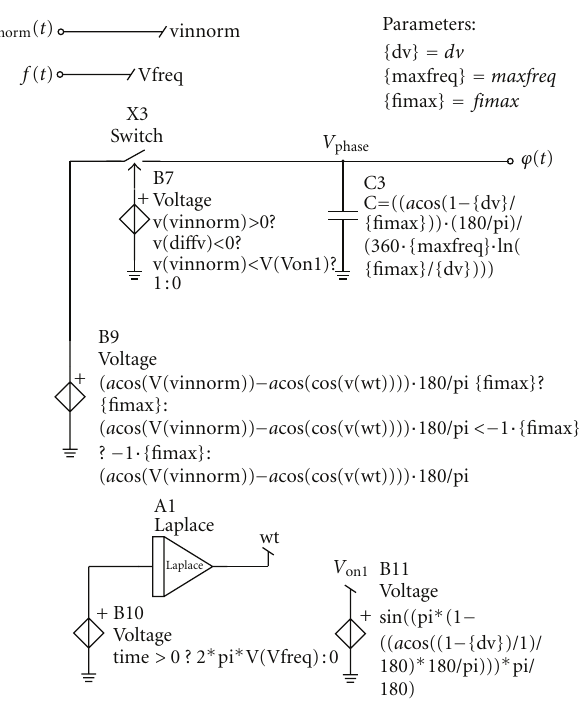
Figure 5: Signal-phase calculator